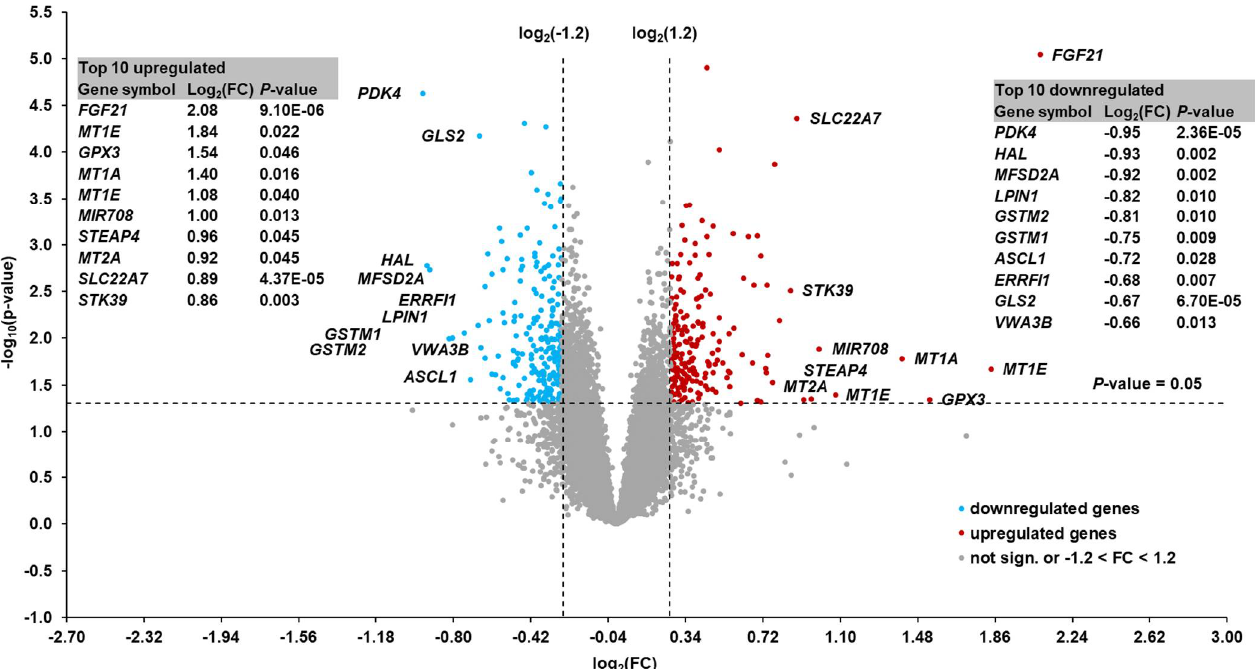
Figure 2. Volcano plot showing hepatic transcripts that were differentially regulated between cows with high and low hepatic FGF21 expression at week 1 postpartum. The double filtering criteria are indicated by horizontal ( p -value < 0.05) and vertical [FC: > log 2 (1.2) or < log 2 ( −1.2)] dashed lines. Transcripts in the upper left and upper right corners represent the downregulated and upregulated transcripts, respectively. The top 10 up- and downregulated transcripts with log 2 (FC) and p -value are shown in the two tables within the figure.